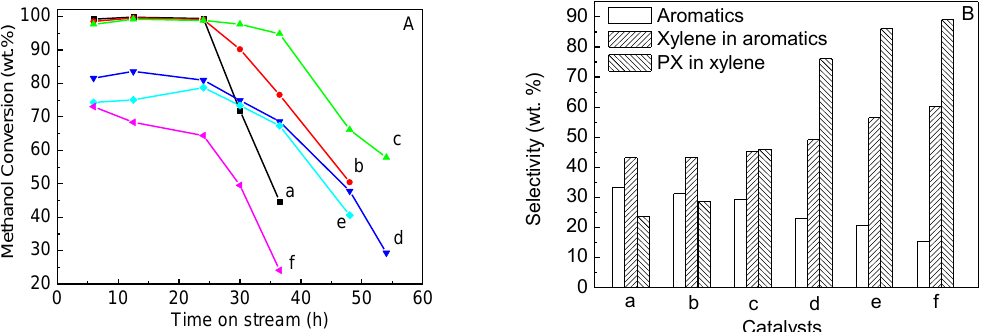
Figure 7. Methanol conversion with the time on stream (TOS) ( A ) and product selectivity at a TOS of 12.5 h ( B ) over parent and P-modified HZSM-5 zeolites: ( a ) HZSM-5, ( b ) 0.5% P / HZSM-5, ( c ) 1% P / HZSM-5, ( d ) 2% P / HZSM-5, ( e ) 3% P / HZSM-5 and ( f ) 5% P / HZSM-5.